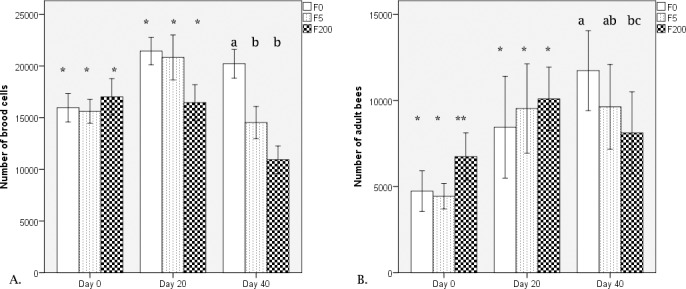
Colony population dynamics.Differences in colony brood and population after 20 and 40 days of treatment with imidacloprid, in the field. Different number of * and different letters above the bars denote significant differences between the groups. F0: field experiment not treated; F5: field experiment treated with 5 ppb imidacloprid; F200: field experiment treated with 200 ppb imidacloprid (average of 10 colonies per treatment).